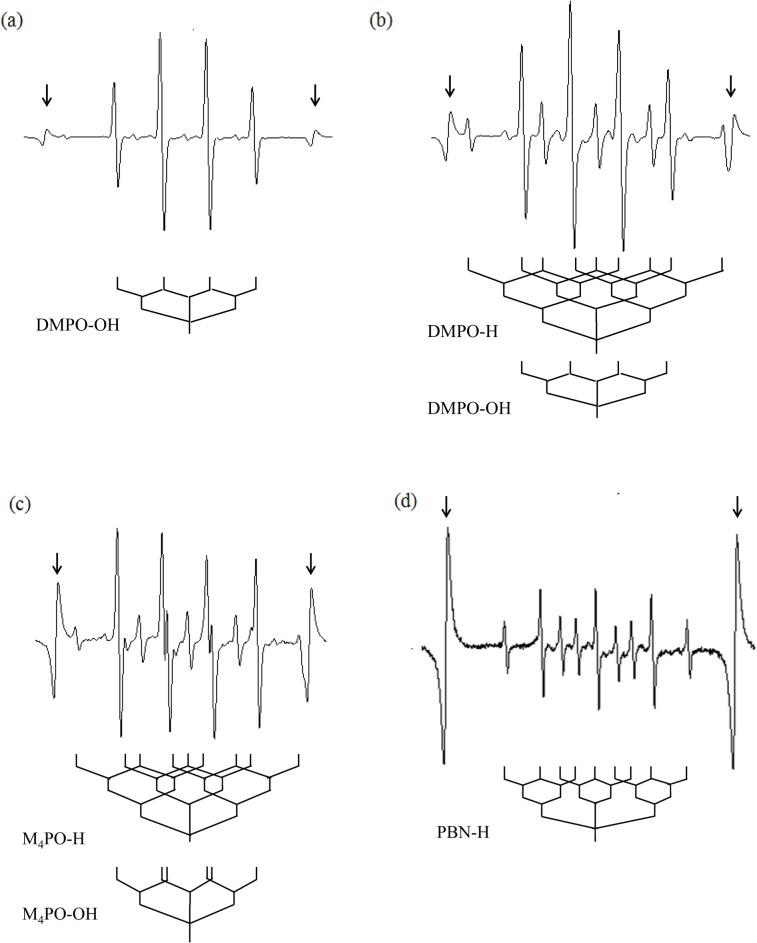
EPR spectra of spin adducts in aqueous solutions irradiated with Ar-CAP for 2 min at 8 mm distance.(a) EPR spectrum of DMPO showing a 1:2:2:1 quartet of DMPO-OH and several other small peaks due to DMPO-H. (b) DMPO aqueous solution irradiated with 5 Gy X-rays showing typical DMPO-OH and DMPO-H peaks. (c) EPR spectrum of M4PO-OH and M4PO-H adducts. (d) EPR spectrum of PBN-H adducts. Arrows indicate internal standard lines.